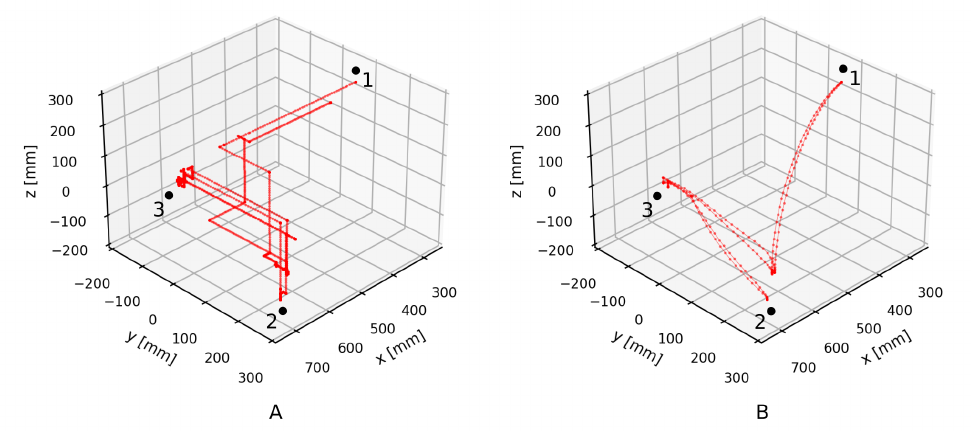
Figure 7. Translation of the robot’s end effector during the evaluation task ( A ) when the operator is manually controlling the robot with a teach pendant and ( B ) when the robot is in automatic mode controlled by a